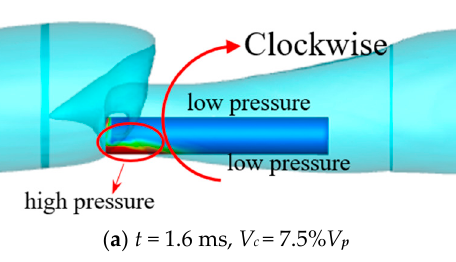
Figure 21. Schematic diagram of the pressure distribution around projectile 2 at two different time points.